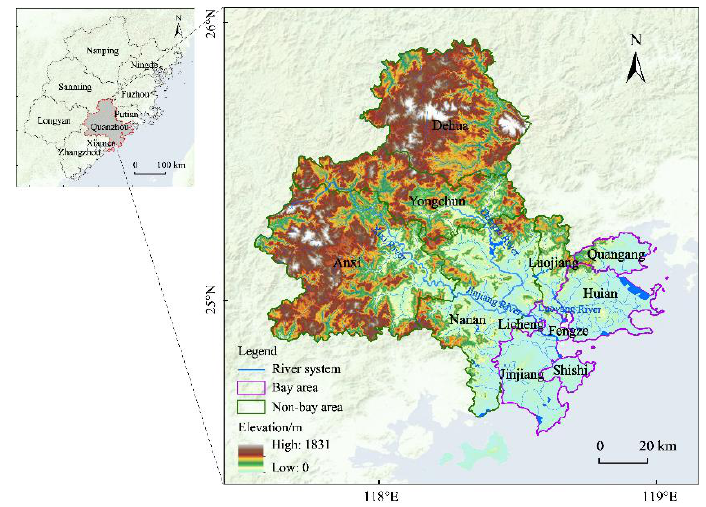
Figure 1. Location of the study area.